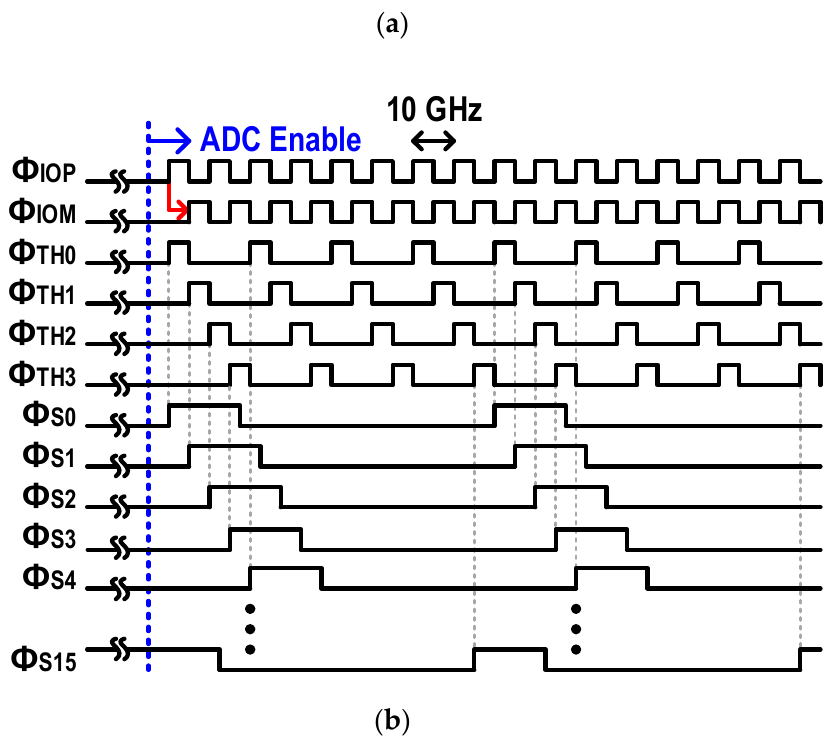
Figure 1. Proposed 6-bit 20 GS/s TI two-step flash ADC. ( a ) Block and ( b ) timing diagrams.